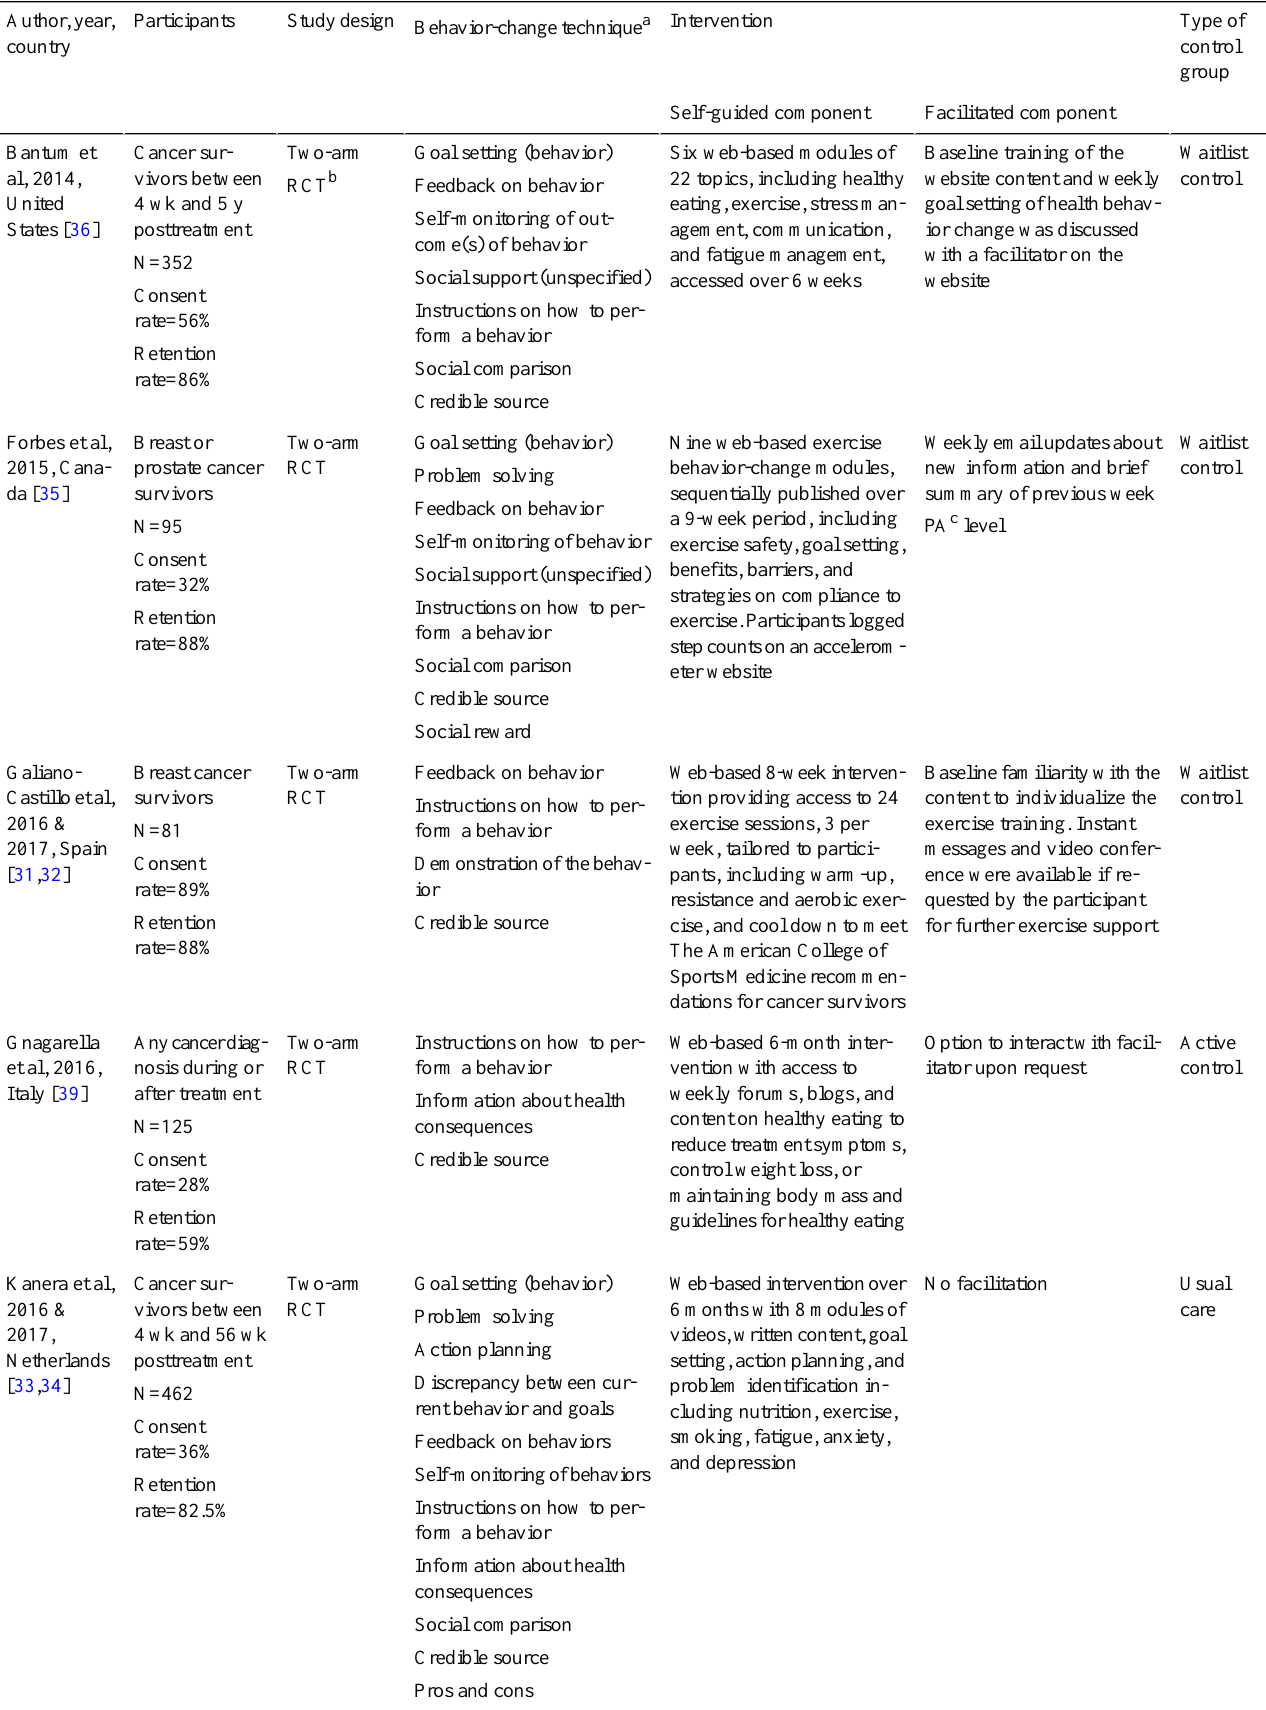
Table 1. Characteristics of the included